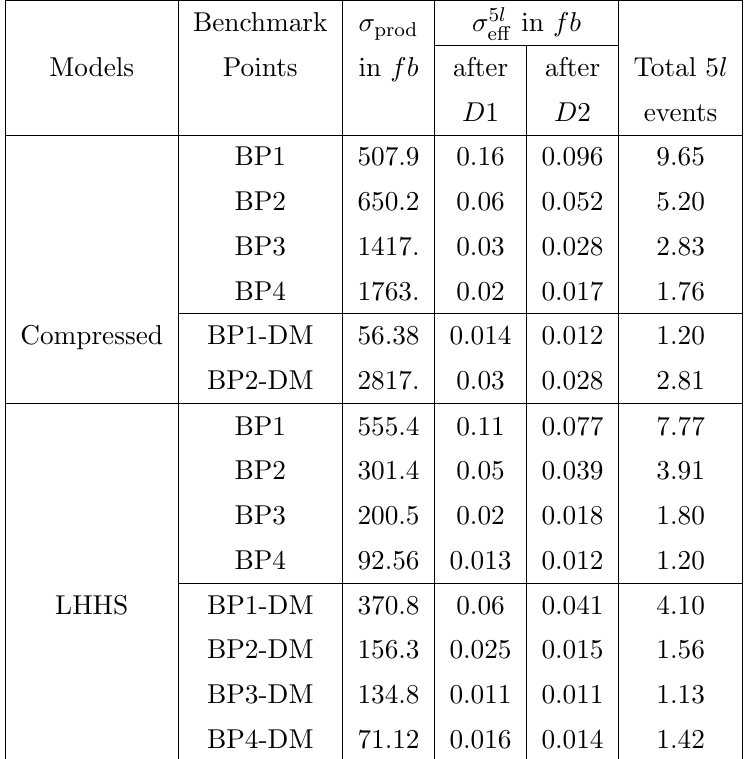
Table 18 . The production cross sections of all EWeakino pairs and (cid:27) 5 l and table 6. Also the total number of 5 l events are shown for an integrated luminosity of 100 fb (cid:0) 1 .